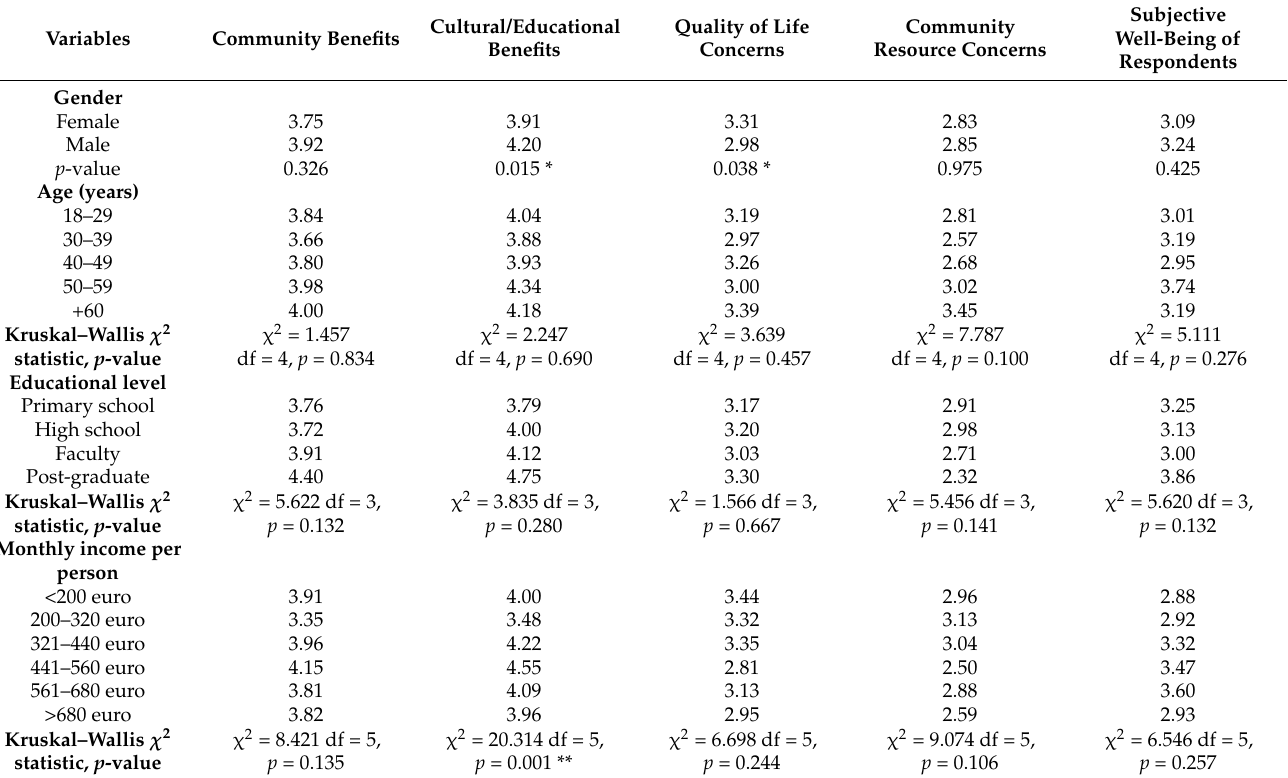
Table 5. Importance of tourism